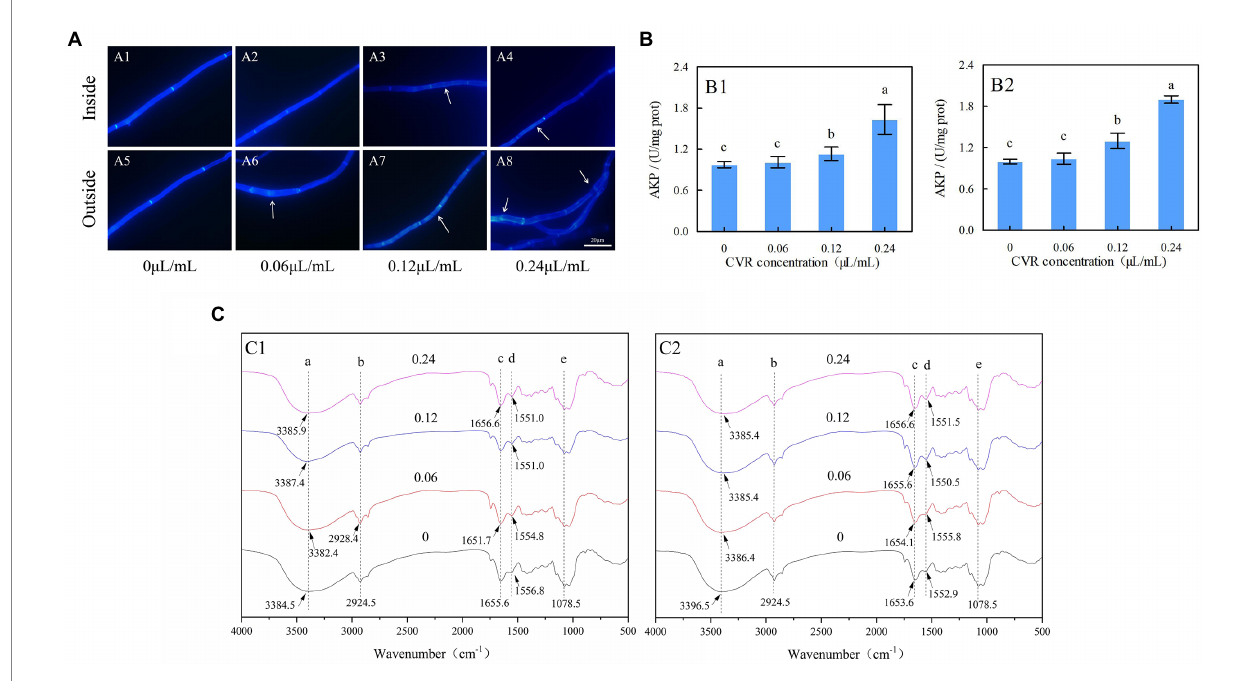
FIGURE 1 Alternaria alternata treated with CVR and observed under a fluorescence microscope after CWF staining (×100 magnification). (A) CK treatment of inside (A1) and outside (A5) parts of mycelia; 0.06 μl/ml CVR treatment of inside (A2) and outside (A6) parts of mycelia; 0.12 μl/ml CVR treatment of inside (A3) and outside (A7) parts of mycelia; 0.24 μl/ml CVR treatment of inside (A4) and outside (A8) parts of mycelia, respectively, (B) The effect of AKP enzyme activity after CVR treatment of inside (B1) and outside (B2) parts of mycelia, and (C) Influence of CVR on cell walls of A. altern ata. Different